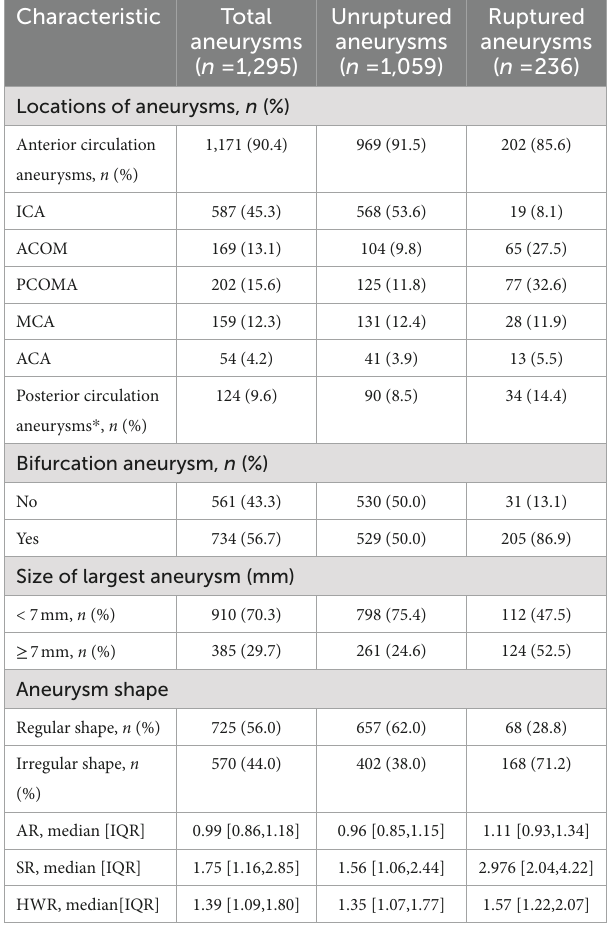
TABLE 3 Aneurysm